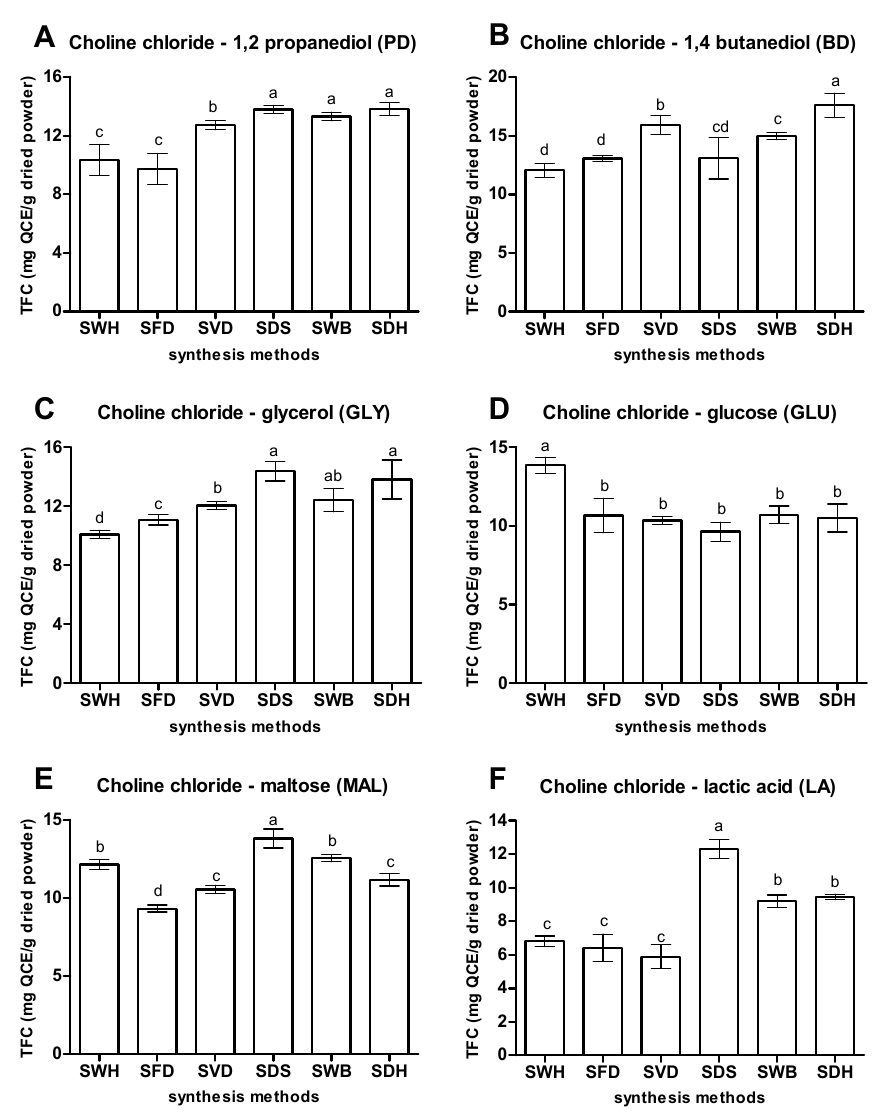
Figure 3. Effect of different synthesis methods of NaDES. ( A ) Choline chloride—1,2 propanediol,